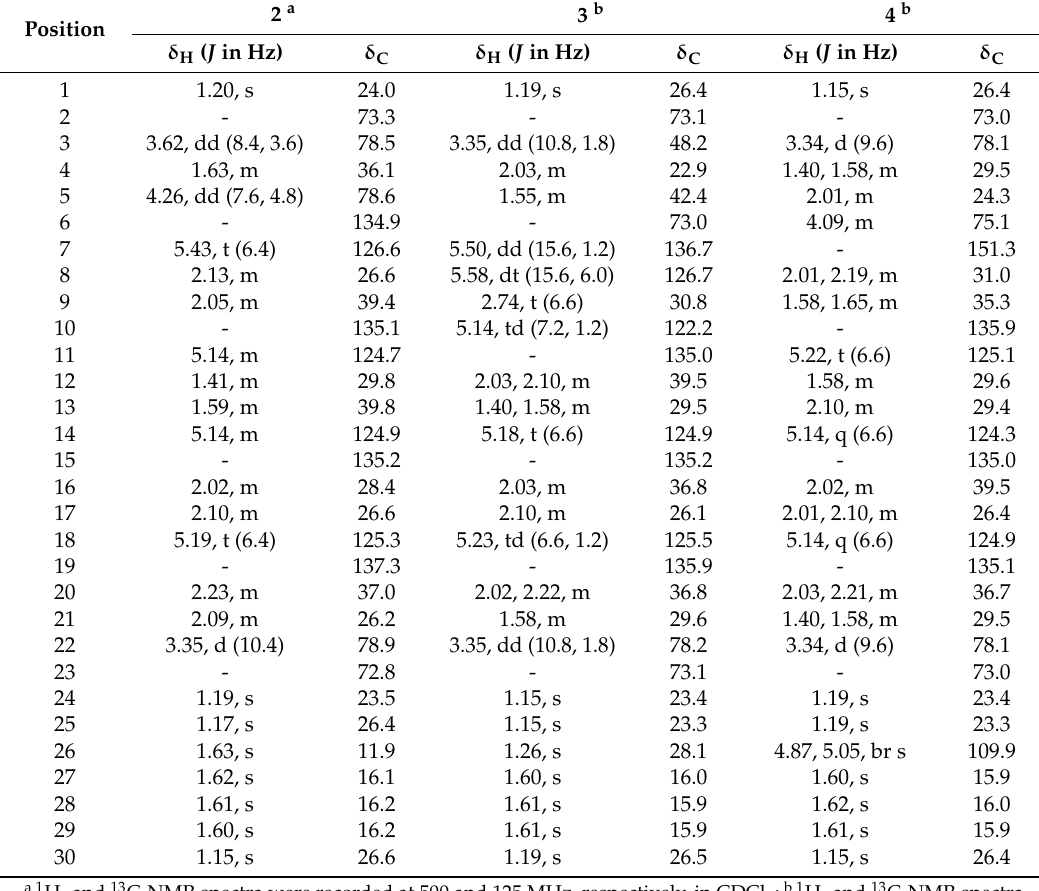
Table 1. 1 H- and 13 C-NMR Spectroscopic data of Compounds 2 – 4